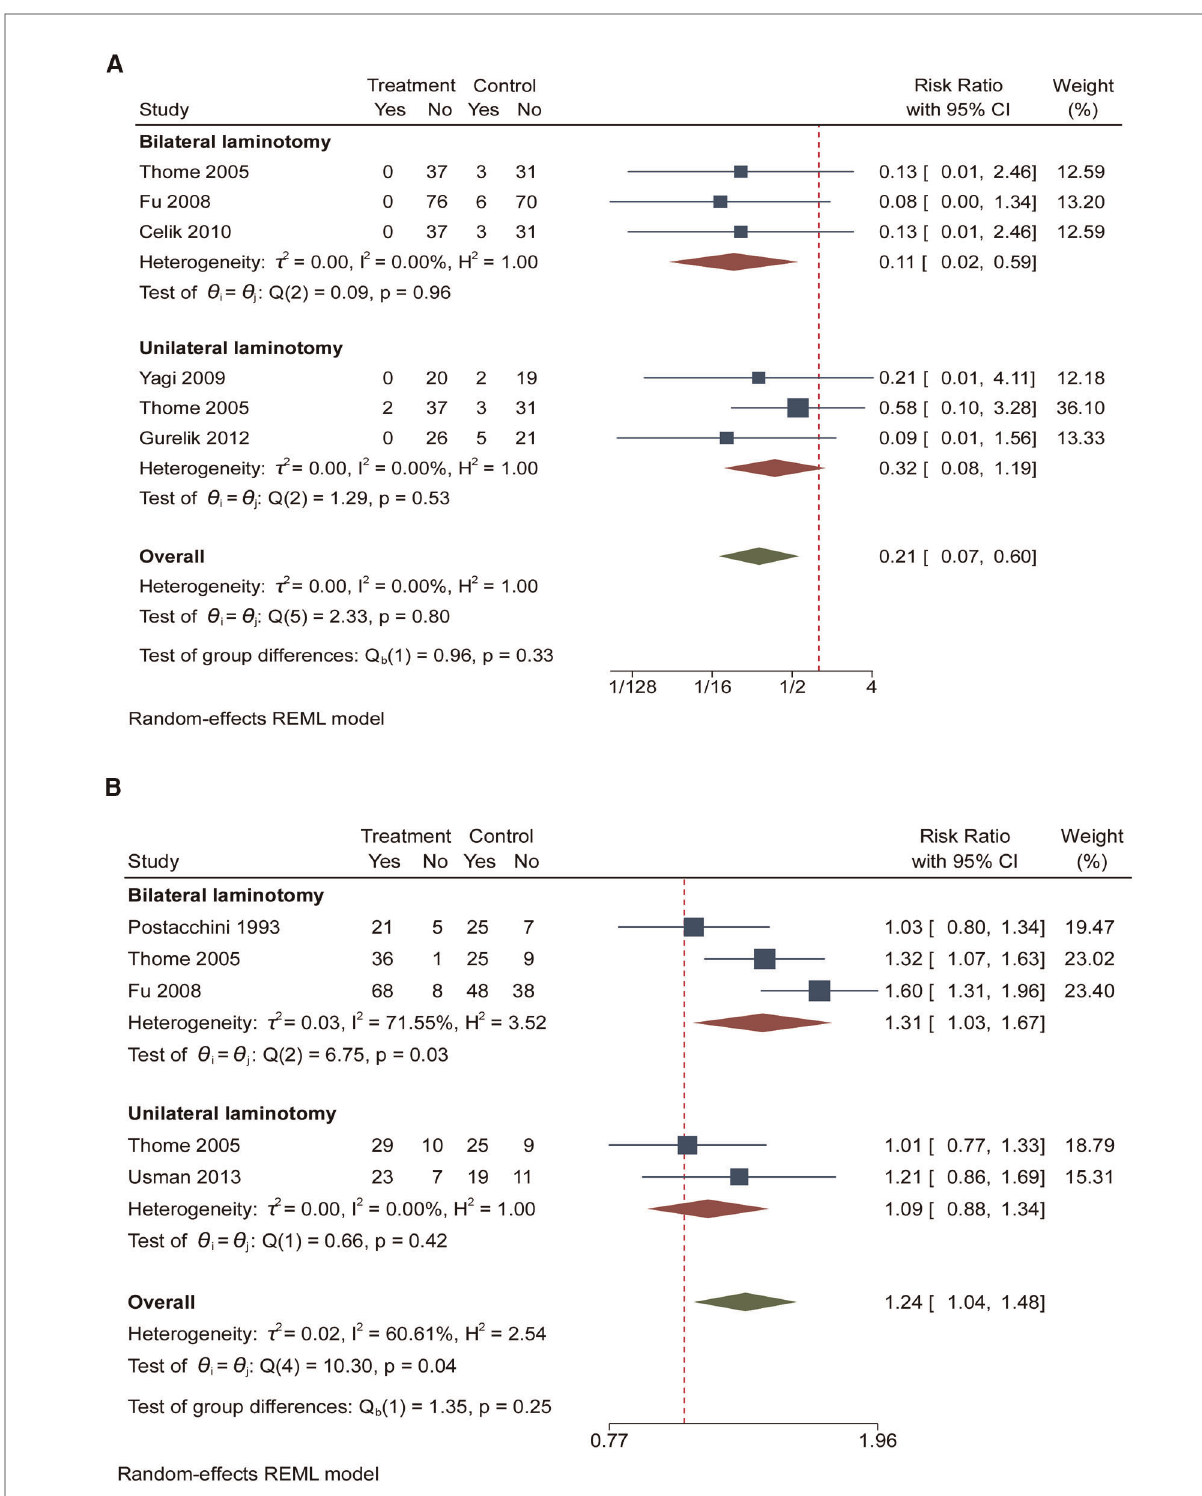
FIGURE 5 ( A ) The forest plot regarding instability compared posterior techniques with tourniquet group. ( B ) The forest plot regarding recovery (good+ excellent) compared posterior techniques with tourniquet